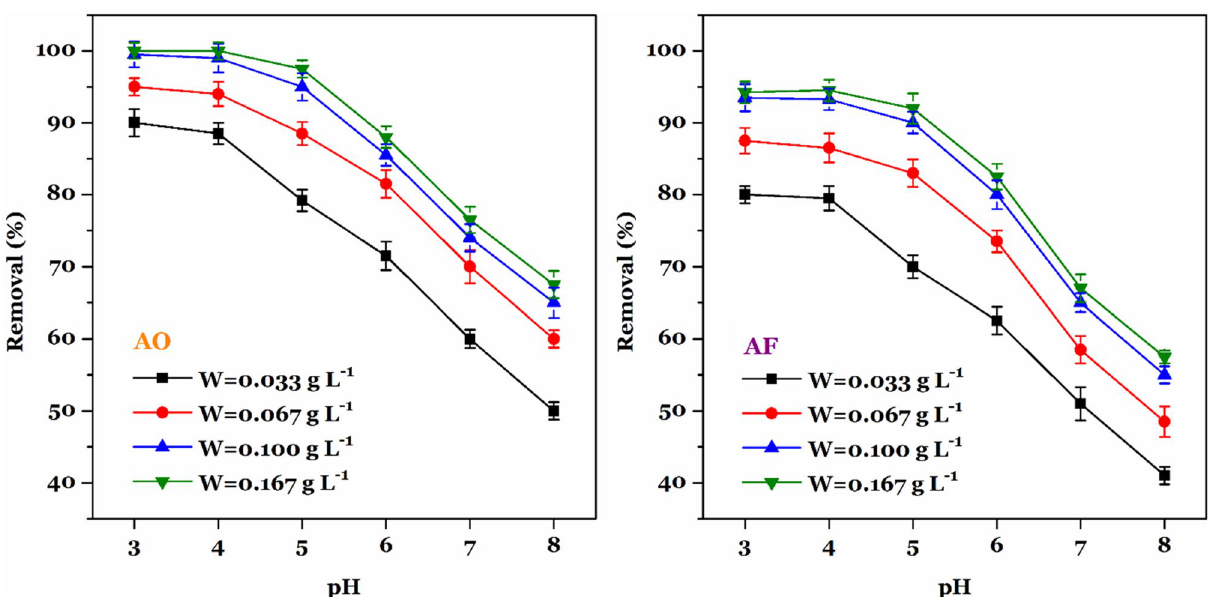
Figure 6. The effect of pH and adsorbent dosage on the removal percentage of AF (left) and AO (right) dyes ( C i = 10 mg L −1 , t = 120 min, T = 25 °C, shaking speed = 180